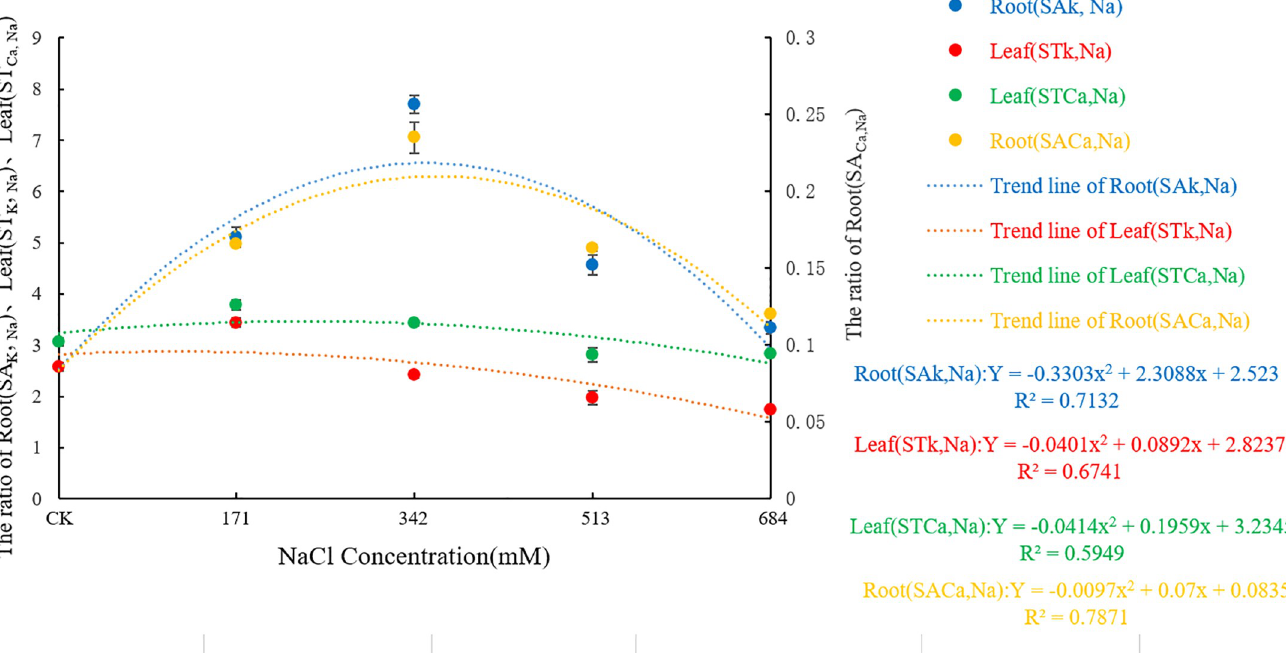
PLOS ONE | https://doi.org/10.1371/journal.pone.0260086 November18,